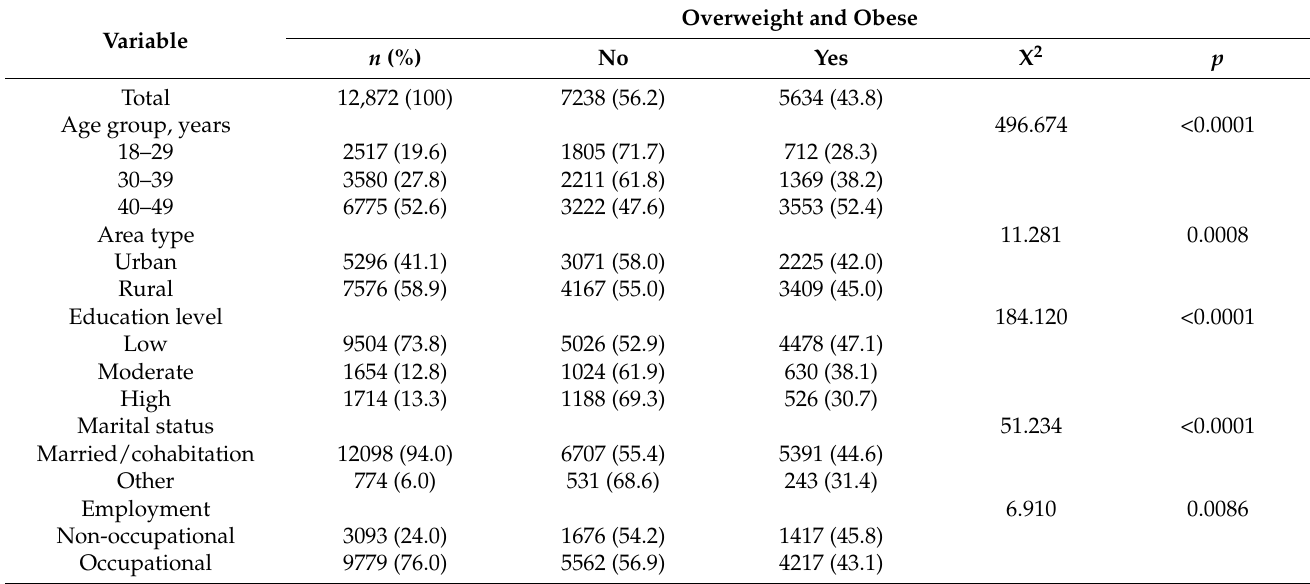
Table 1. Basic information of non-pregnant and non-lactating females aged 18–49 years.